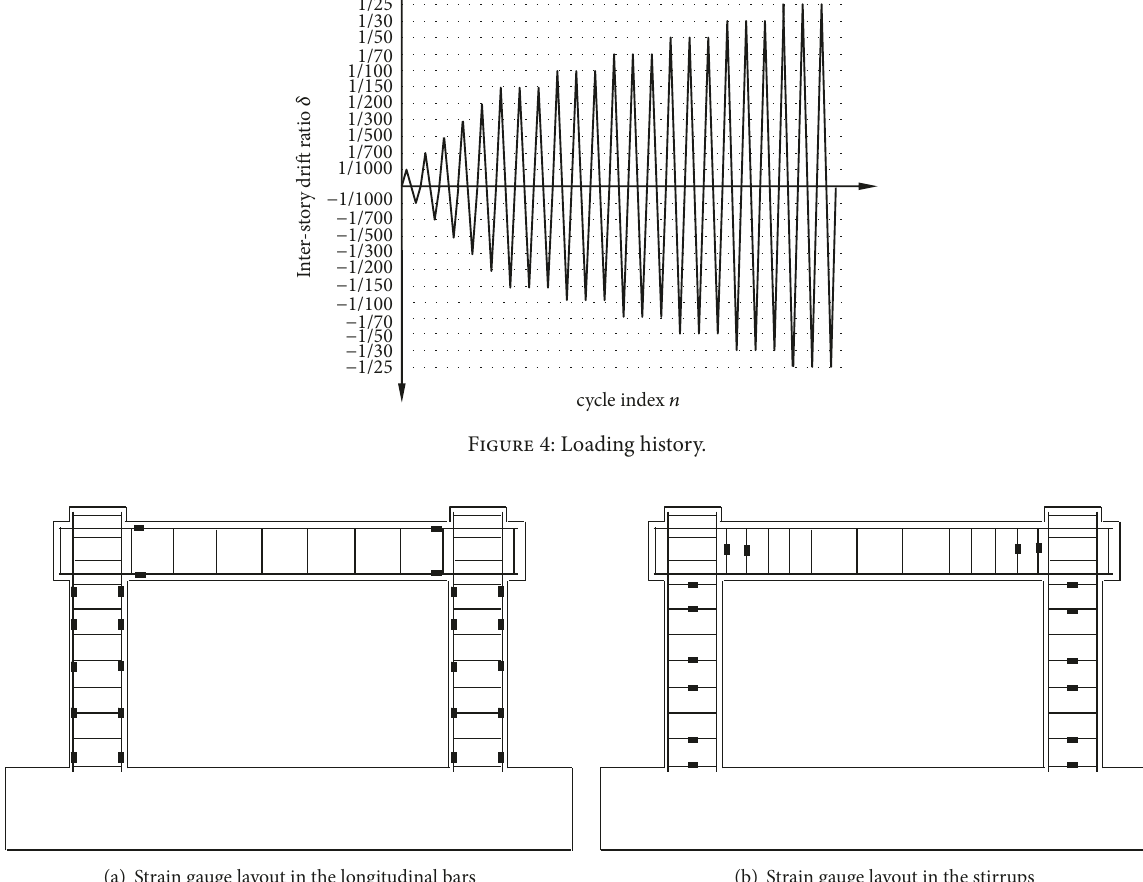
Figure 5: Strain gauge layout in the bars of beams and